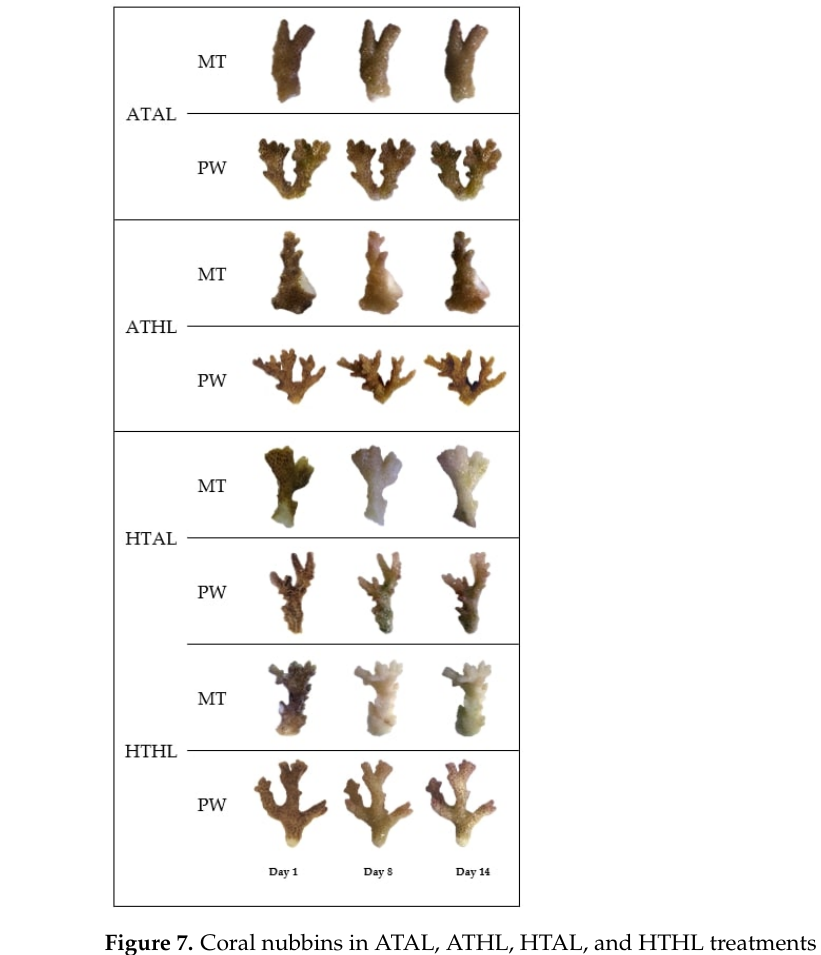
Figure 7. Coral nubbins in ATAL, ATHL, HTAL, and HTHL treatments from MT and PW at initial time (Day 1), last day of increasing temperature (Day 8), and end of the experiment (Day 14).